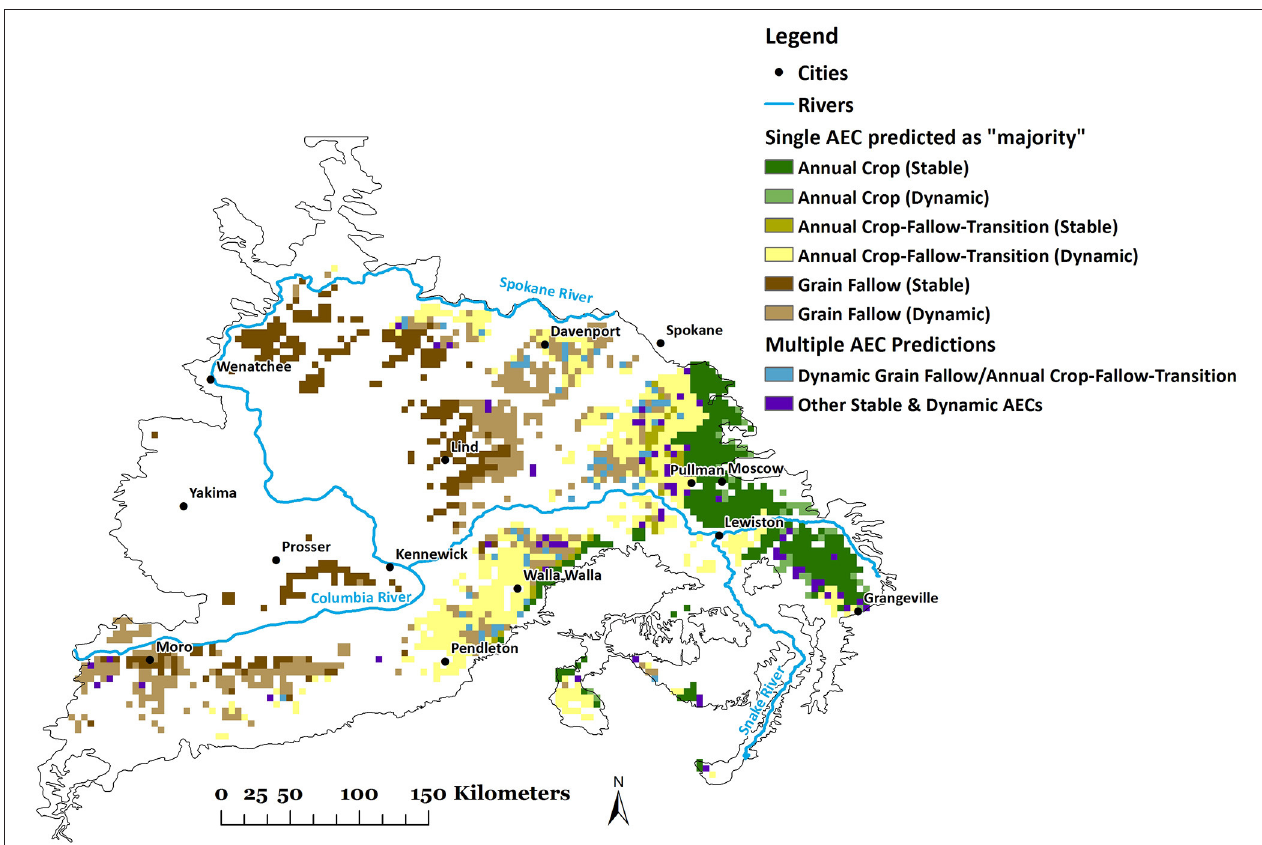
FIGURE 3 | Projected geo-spatial distribution of six (stable and dynamic) agro-ecological classes (AECs) using combined Random Forest (RF) model of bioclimatic variables for six AECs under future climate scenario (2070, Representative Concentration Pathway, RCP-8.5).